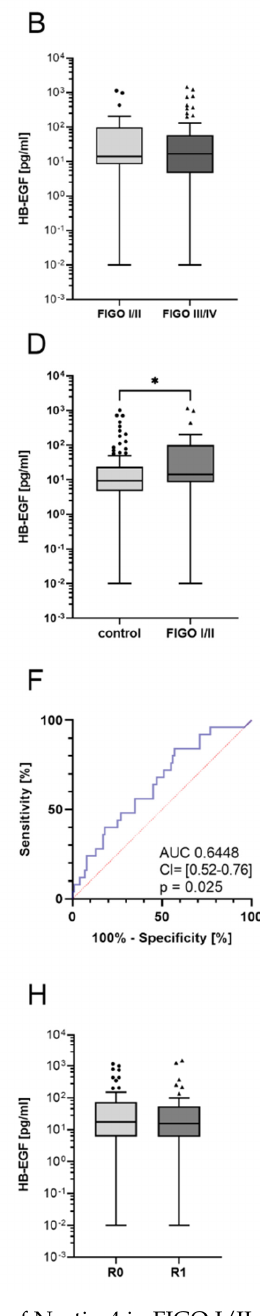
Figure 2. ( A ): Significantly higher concentrations of Nectin-4 in FIGO I/II (26 cases) compared to FIGO III/IV (104 cases), Mann–Whitney test * ( p = 0.043). ( B ): No significant difference in HB-EGF levels between early and advanced FIGO stages, Mann–Whitney test ( p = 0.59). ( C ): Nectin-4 levels were significantly increased in FIGO I/II stages (26 cases) vs. 100 healthy controls, Mann–Whitney test **** ( p < 0.0001). ( D ): Significantly elevated HB-EGF levels between control group vs. early FIGO I/II stages, Mann–Whitney test * ( p = 0.025). ( E ): Receiver operating characteristic (ROC) of Nectin-4. ( F ): ROC curve of HB-EGF. ( G ): Significantly elevated Nectin-4 levels in 72 patients without macro- scopic tumor remnant (R0) compared to 56 patients with macroscopic tumor remnant (R1), Mann– Whitney test ** ( p = 0.0021). ( H ): No increased HB-EGF levels between R0 and R1. Mann–Whitney test ( p = 0.74). All panels except for E and F show